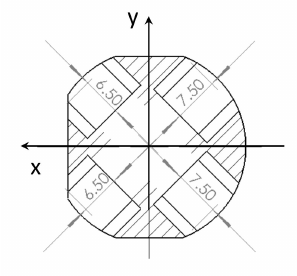
Figure 12. Slots radial